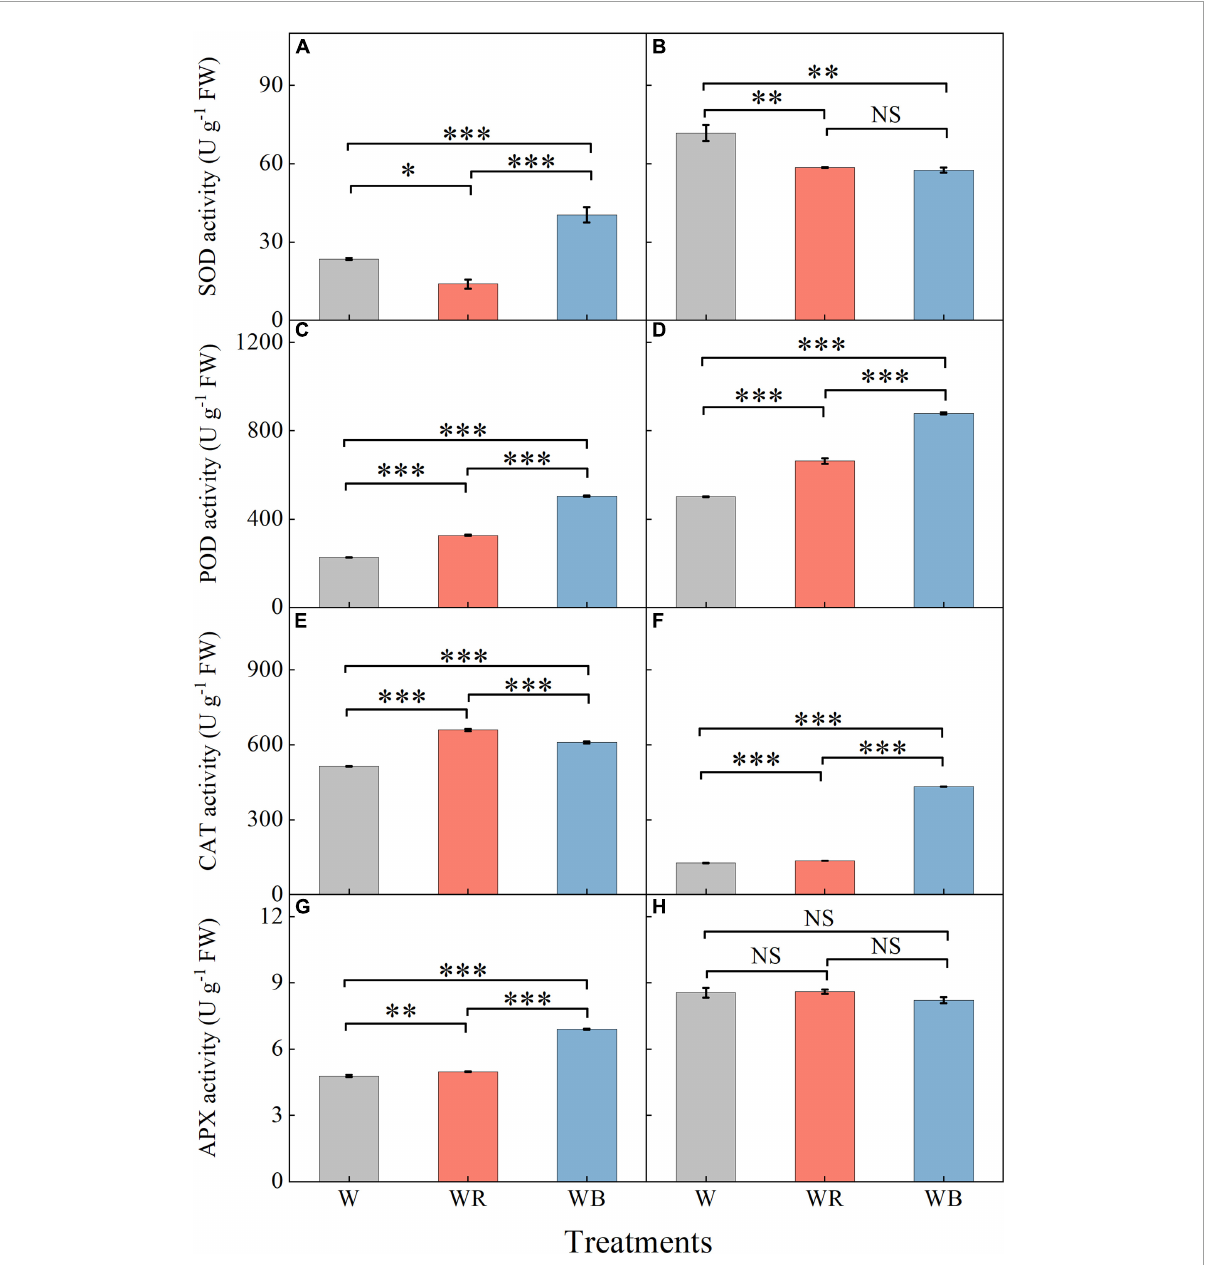
FIGURE6 The activities of SOD, POD, CAT, and APX in extracts of wheat seedlings leaves (A,C,E,G) and stems (B,D,F,H) under different treatments. Values represent the mean ± SE ( n = 3). The symbols ∗ , ∗∗ and ∗∗∗ indicate significance at the 0.05, 0.01, and 0.001 levels, respectively. NS, not significant, according to the Duncan’s